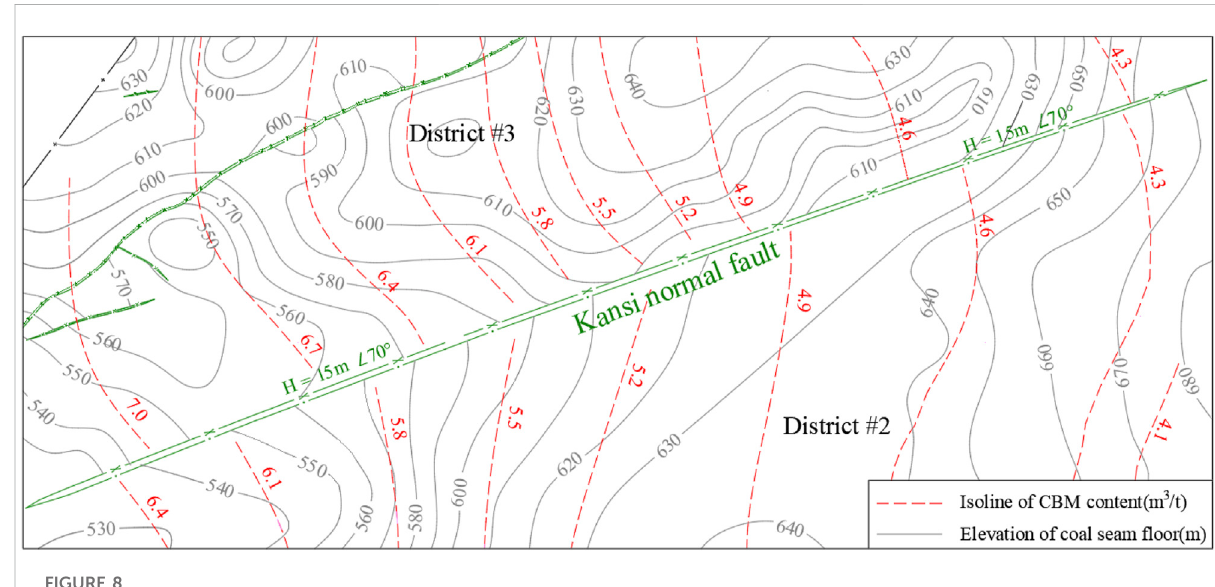
FIGURE 8 Gas content and elevation of the coal seam fl oor around Kansi